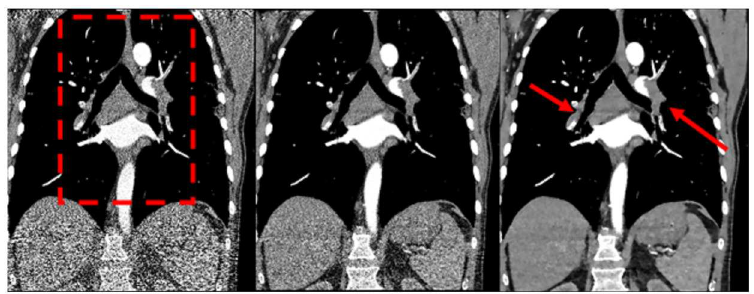
Fig 3. Comparison of FBP, iDose and IMR—coronalview at fulldose. Coronaltomographic slices of a 72-year-old male patient.The imageswere reconstructed with FBP, iDose and IMR (fromleft to right)at full dose (100%dose-level, meaning85 mA, 100 kV and 2.25 mSv for this patient).Centraland segmental pulmonary embolican be clearlyidentified(arrows). The red dashed rectangleindicatesthe enlargedview in Fig 4. FBP = filteredback projection , iDose= iterative dose reduction , IMR = iterative modelreconstruction